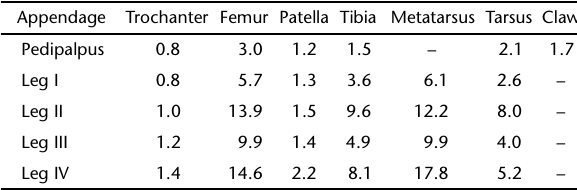
Table I. Appendage measurements of the male holotype of Metarthrodes oxum sp.